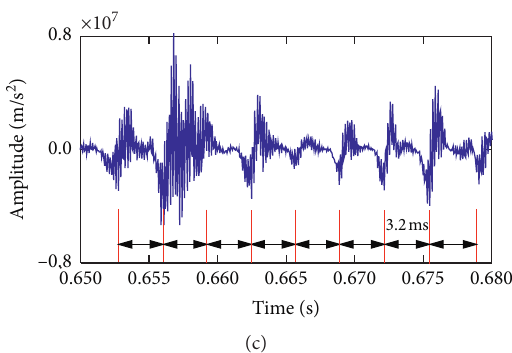
Figure 19: The experimental signal denoising results of wind turbine generator: (a) fitness convergence curve for PPCA optimization; (b) time-domain diagram after noise reduction by APPCA; (c) a partial enlarged view of the denoising